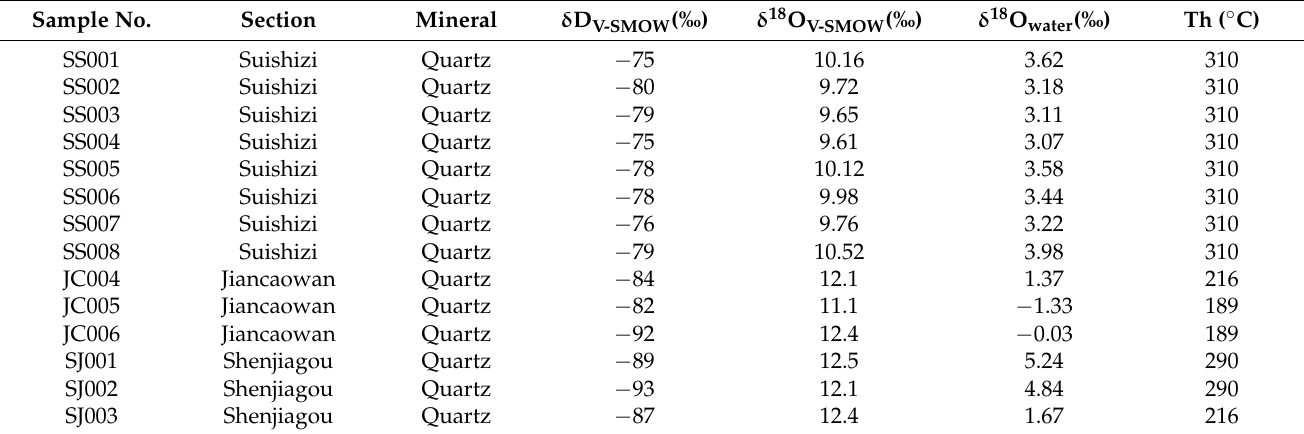
Table 3. δ 18 O and δ D values for Liziyuan gold